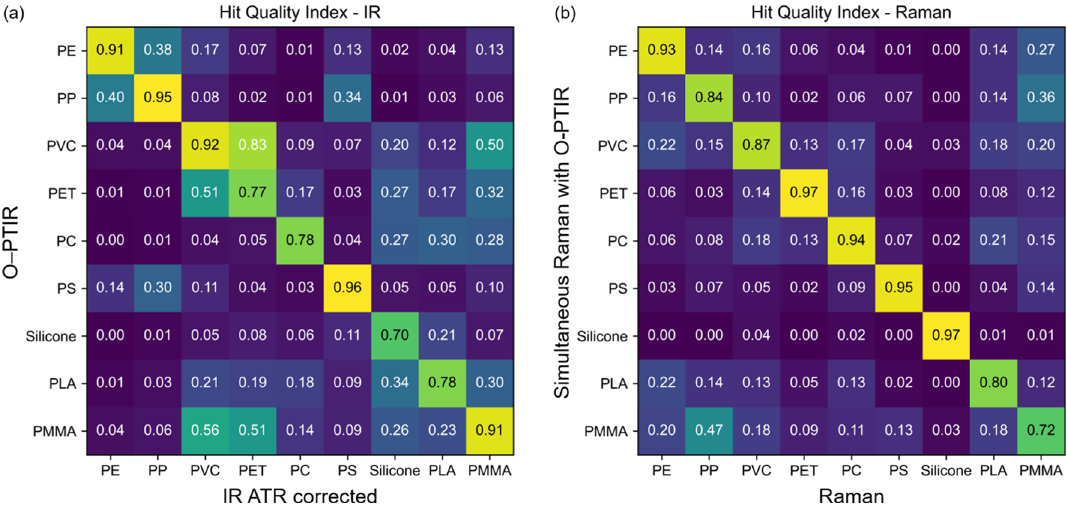
Figure 3. Hit quality index (HQI) of the acquired IR spectra from the FTIR system and the O-PTIR instrument ( a ) and the Raman spectra of the standalone Raman system and the Raman option of the O-PTIR instrument ( b ). The values are color-coded from dark violet to yellow to improve